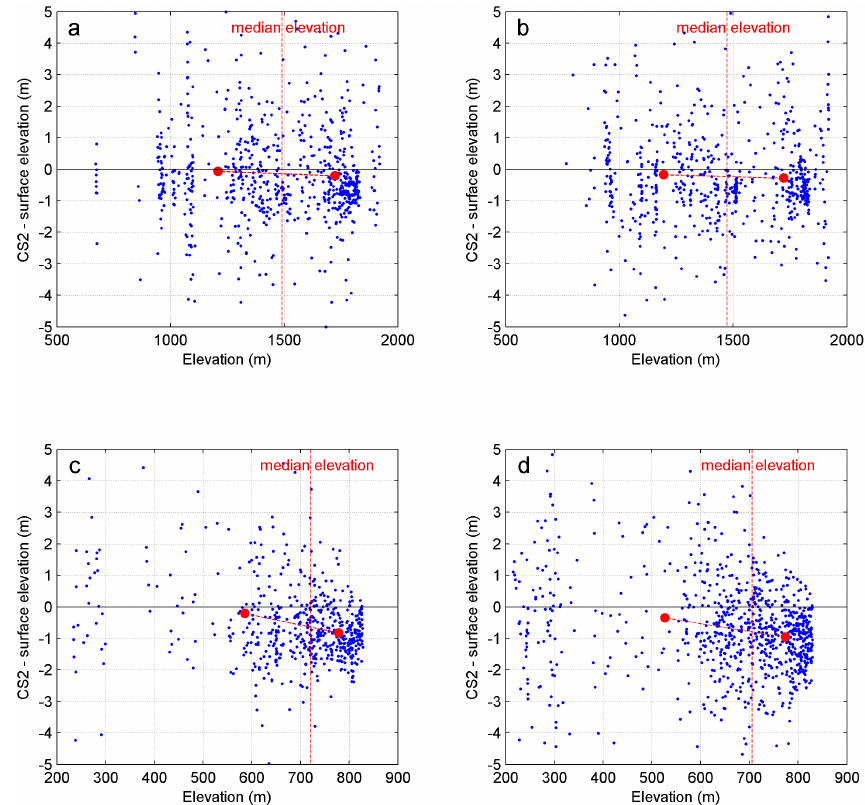
Figure 5. Biases between CS2 elevations and adjacent reference heights plotted against elevation for Devon ( a 2011 and b 2012) and Austfonna ( c 2011 and d 2012). The red markers indicate the average biases above and below the median